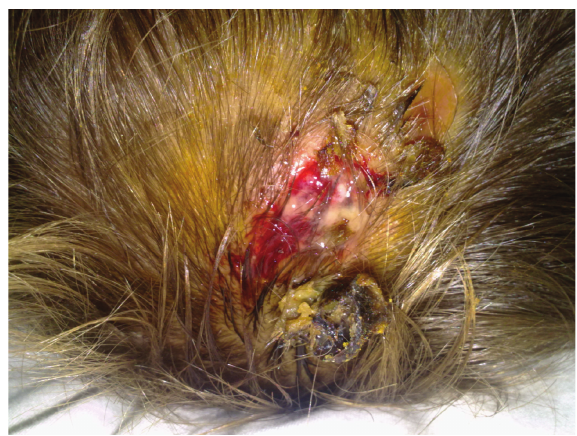
Figure 1: A view of purulent stream and tender swelling on the patient’s lateral half of scalp.